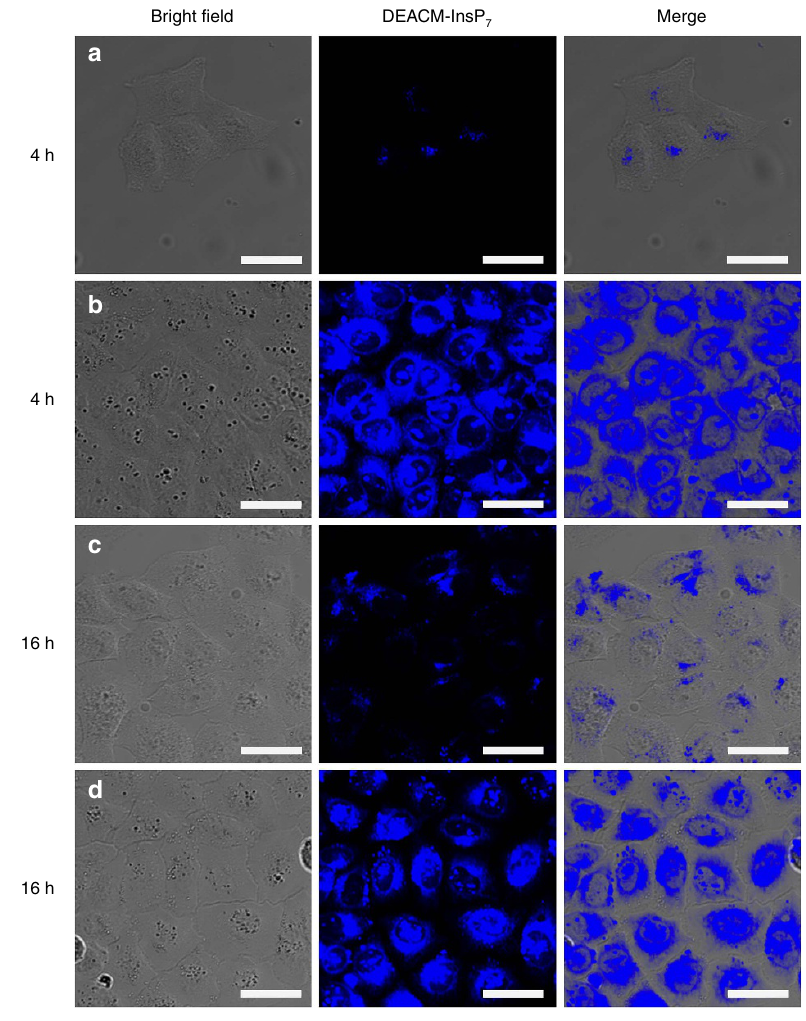
Figure 5 | The molecular transporter 11 delivers photocaged 5-InsP 7 9 into the cytoplasm. Confocal microscopy analysis of HeLa cells incubated with 5 m M DEACM–InsP 7 9 in the presence or absence of transporter 11 after 4 and 16h of incubation. Efficient uptake of 9 is demonstrated by blue coumarin fluorescence emitted from the compound. Cells treated with ( a ) 9 alone for 4h, ( b ) 9 þ 11 for 4h, ( c ) 9 alone for 16h and ( d ) 9 þ 11 for 16h. Scale bars, 35 m